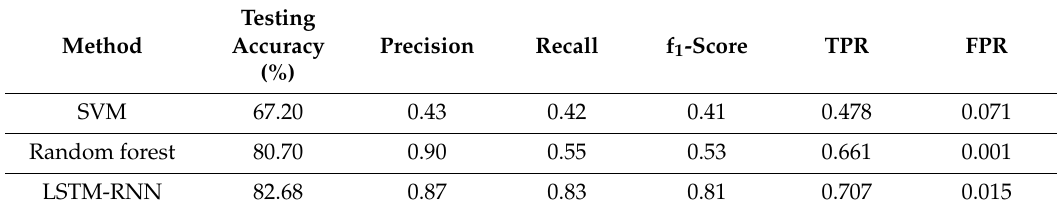
Table 11. Performance comparison for multi-class classification using 122 features.